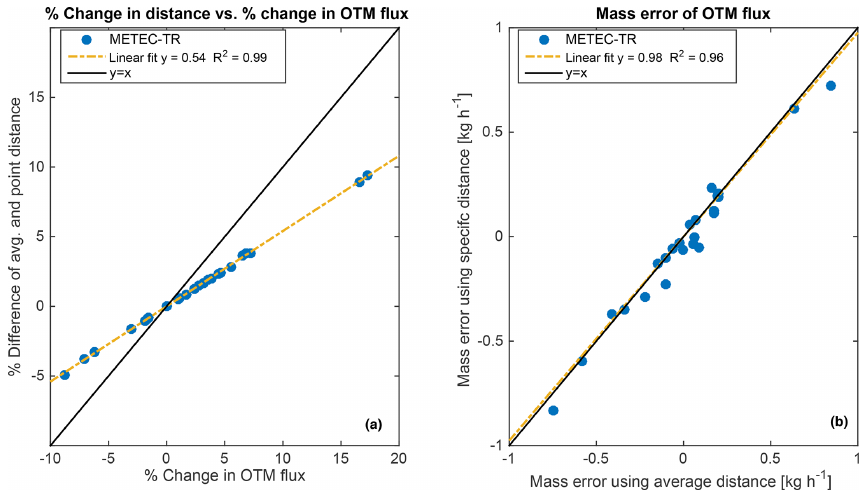
Figure 9. (a) Correlation between percent change in distance ( ( Avg. distance − point )/ point · 100), and resulting percent change in OTM flux ( ( OTM avg − OTM )/ OTM · 100). (b) OTM 33A flux mass error compared to the METEC known release when using average versus known source